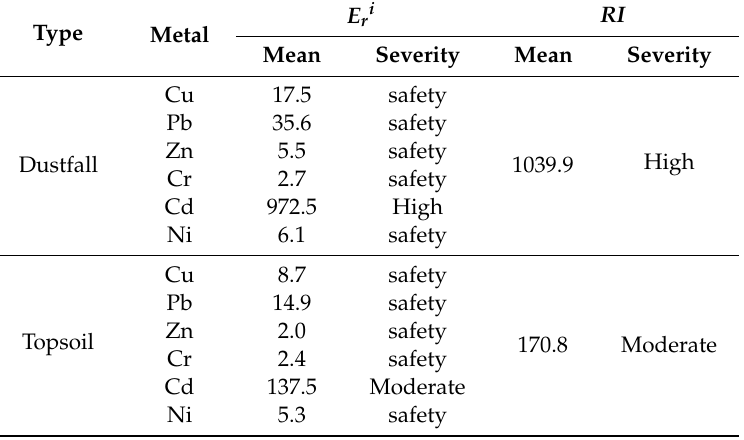
RI refers to the sum of potential ecological risk indexes of various